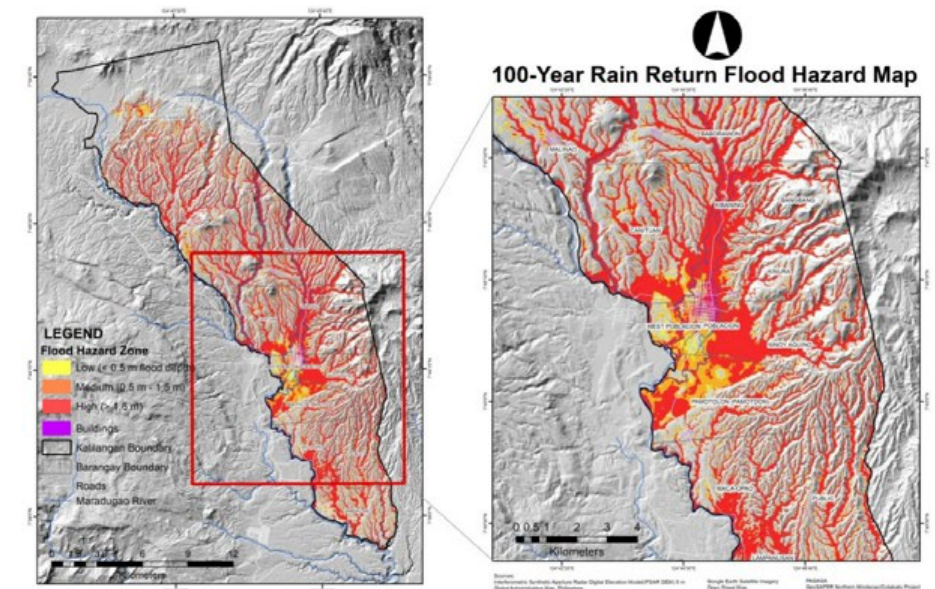
Fig. 8: Flood hazard map of 100-year return period